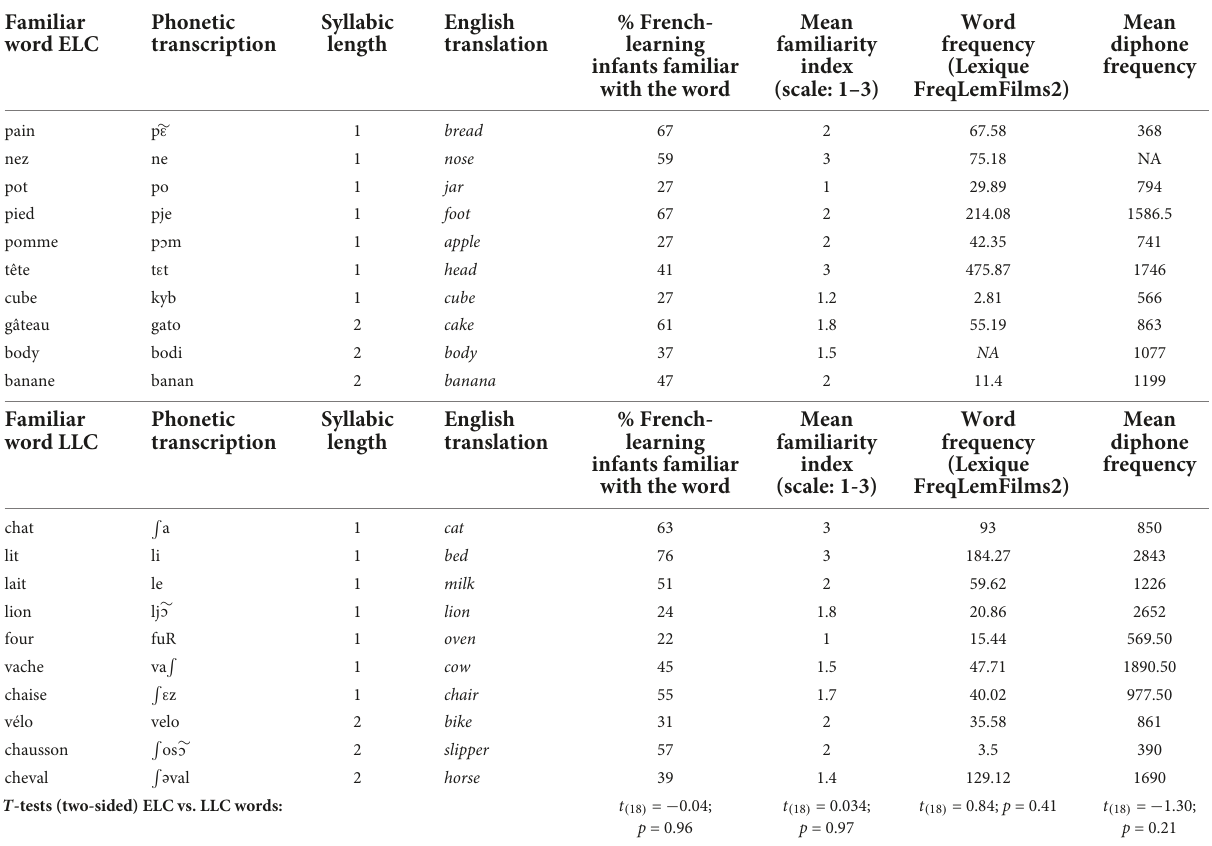
TABLE 4 Test stimuli used in experiment 2: familiar words containing early- vs. late-learned consonants (ELC; LLC). Familiar word ELC